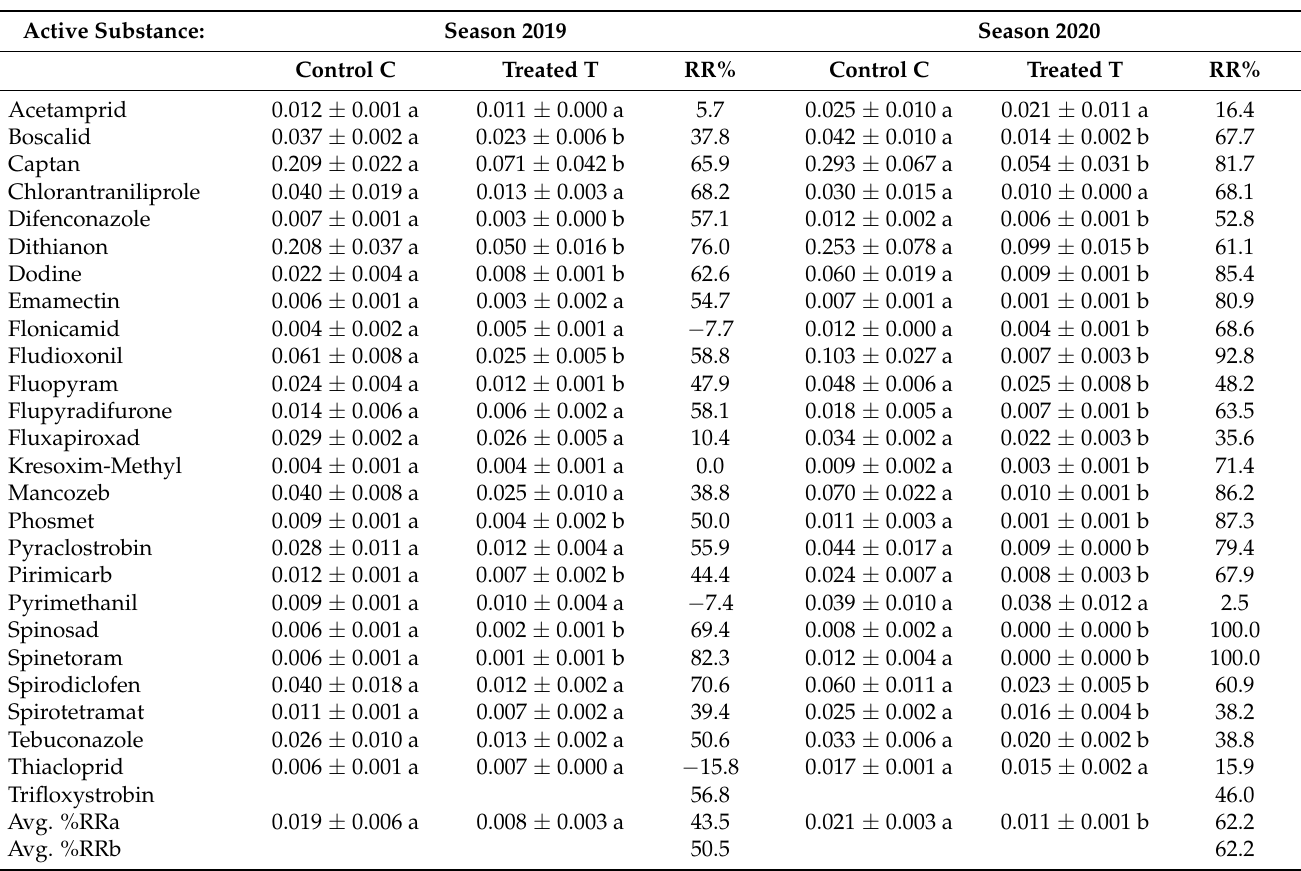
Table 2. Average concentration of pesticide residue ( ± SE) in apples at picking time (mg kg − 1 ) in relation to treatment with hydrogen peroxide; four times preharvest at a rate of 10 L (35% HP) Stabilized peroxide ® /1000 l water/ha.